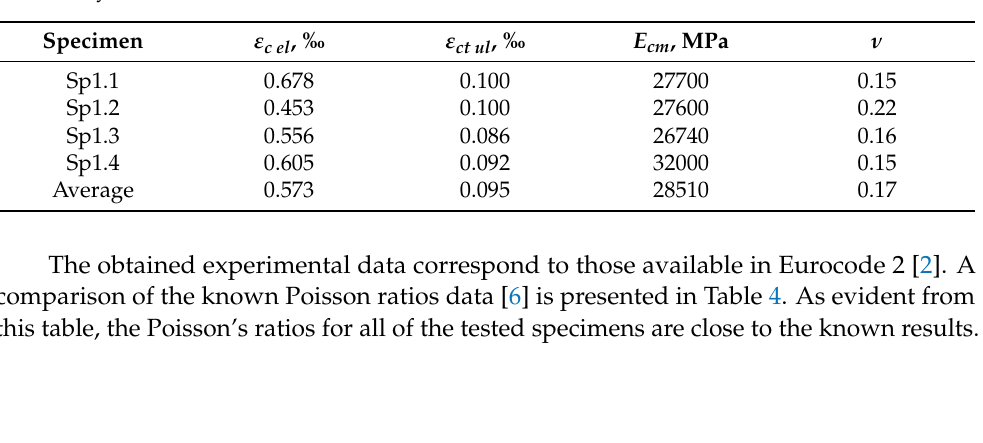
Figure 5. Experimental dependences 𝜎 (cid:3030) vs. 𝜀 (cid:3047)(cid:3045)(cid:3028)(cid:3041)(cid:3046) .